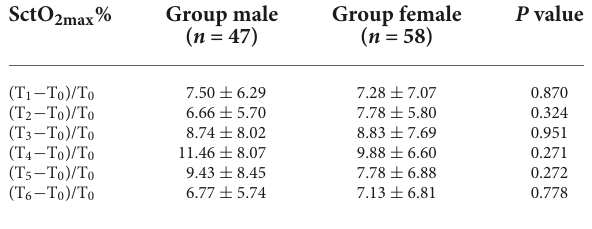
TABLE 4 Comparison of SctO 2max % between males and females at different time points in the group PND and group Non-PND. SctO 2max %